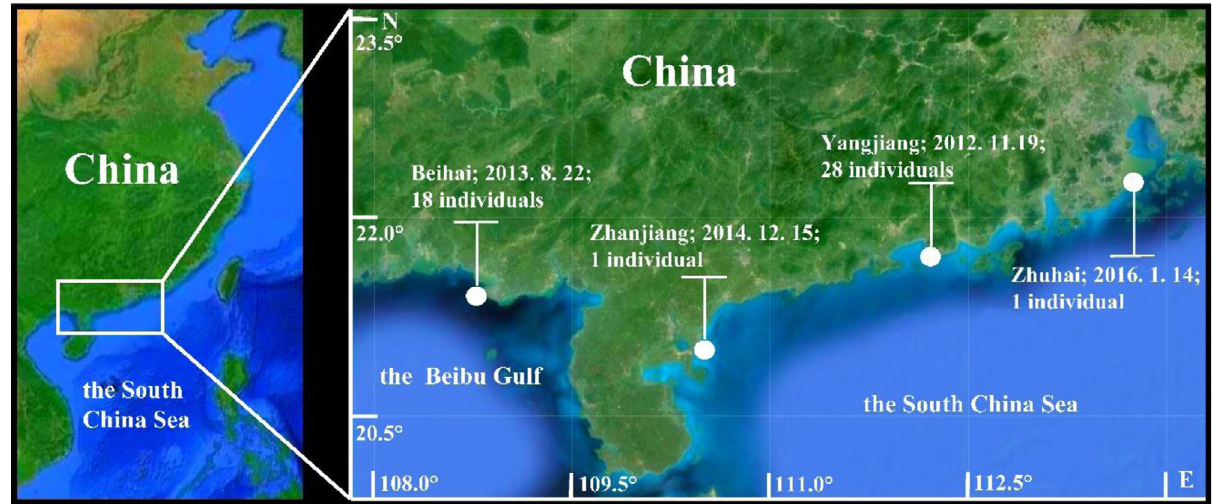
Fig. 1. Sampling location, date, and number of Platycephalus cultellatus individuals in this study. To better show the sample distribution, a smaller scale map was used in the left and its partial enlarged drawing in the